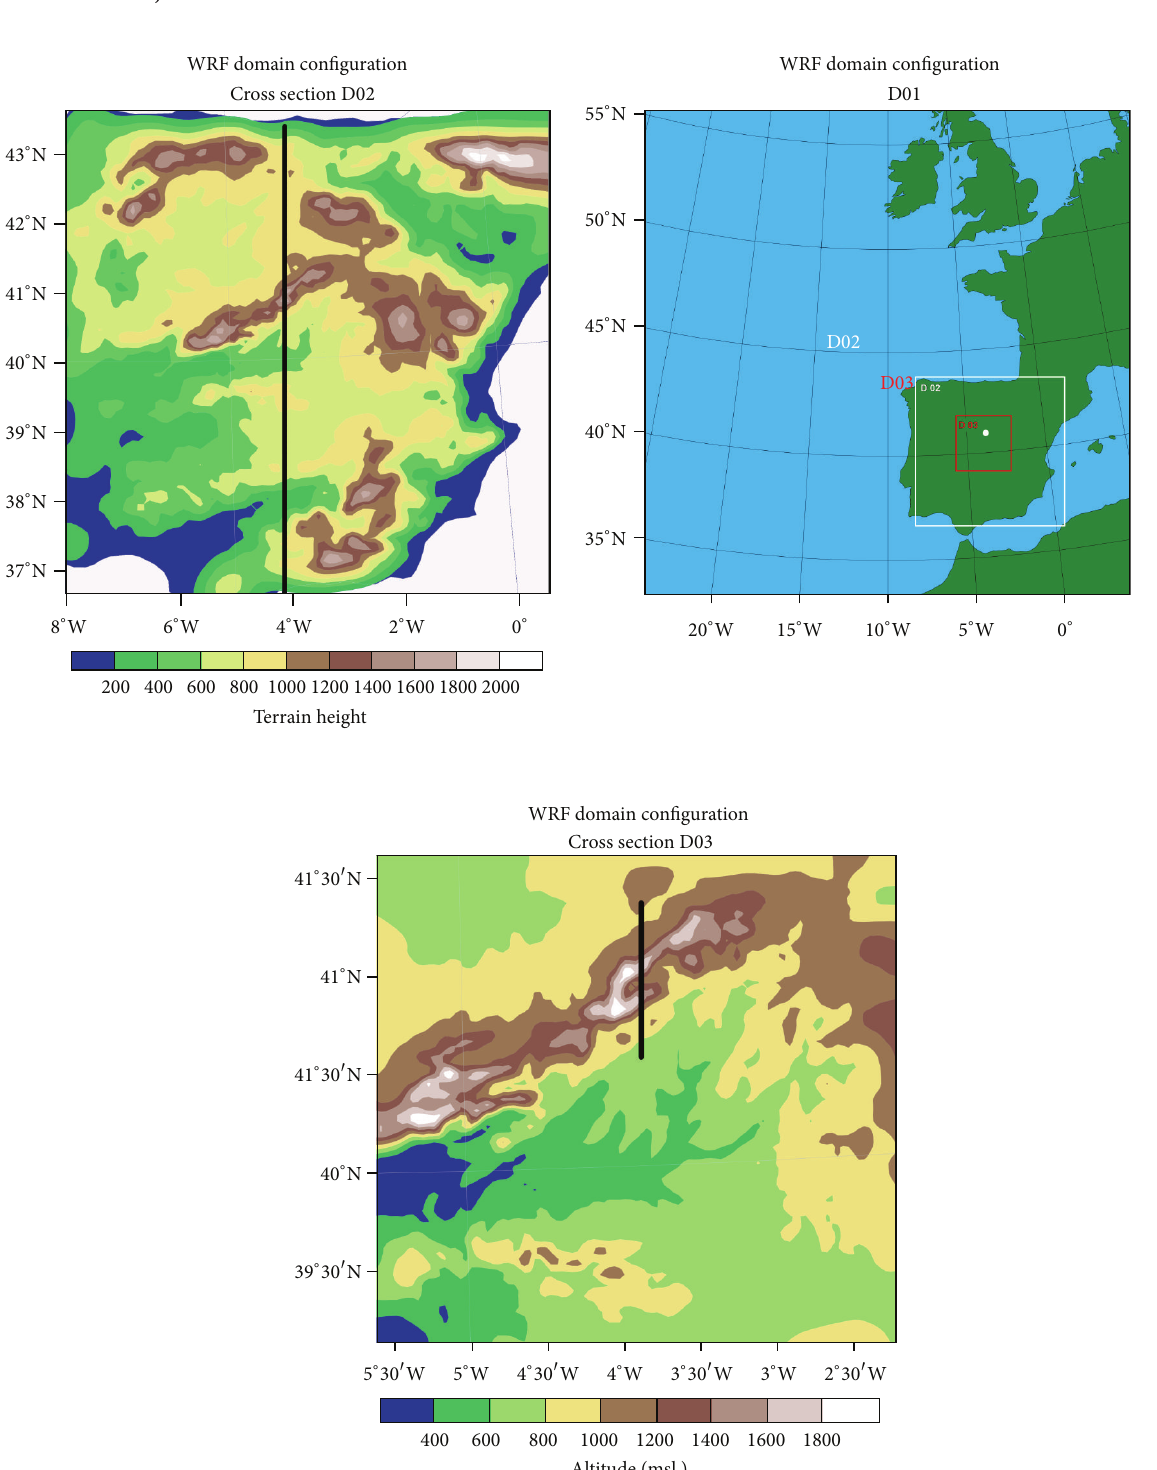
used in forecasting and evaluation of in-cloud icing condi- tions